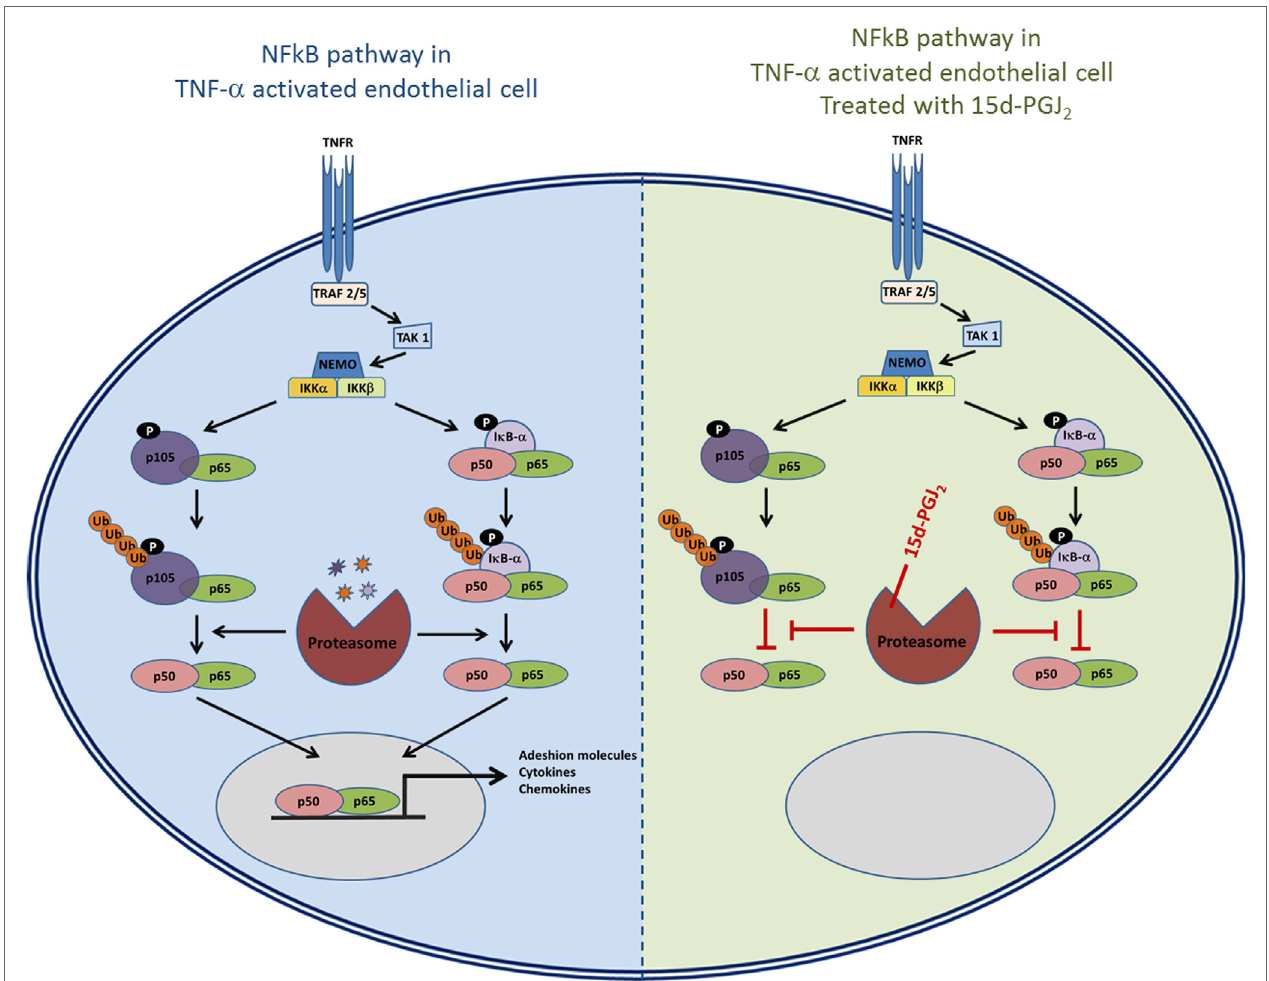
FigUre 7 | The role of proteasome in the nF- κ B pathway and the possible effects of inhibition of proteasome activity by 15d-PgJ 2